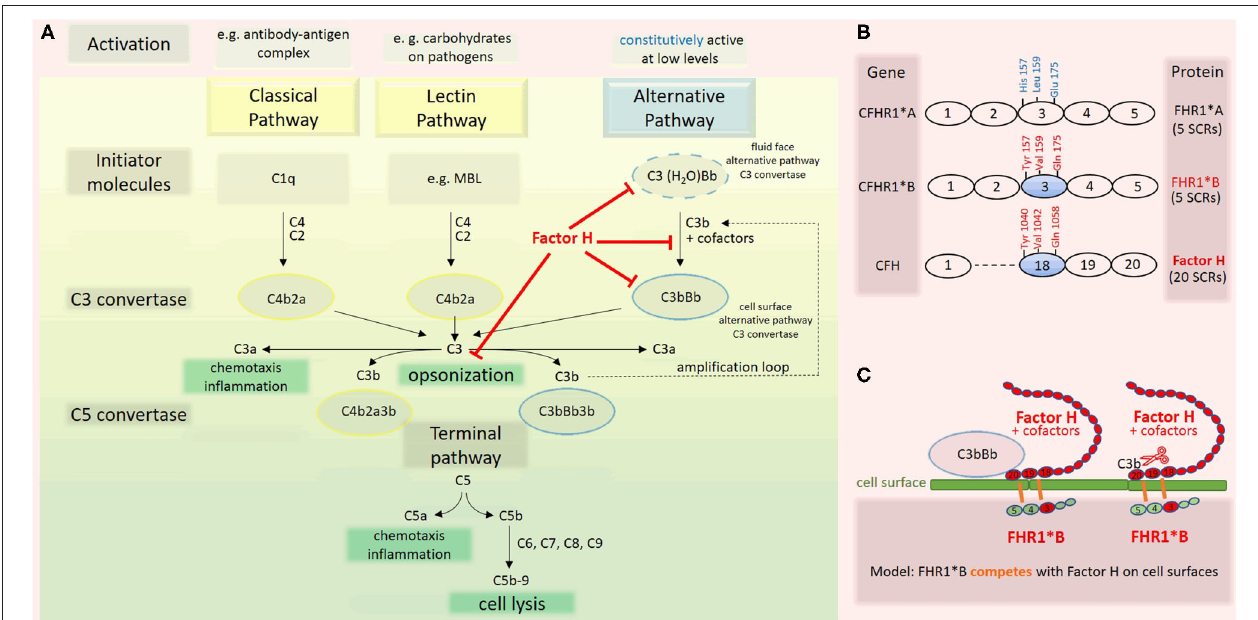
FIGURE 2 | Complement activation cascade. Factor H and factor H related (FHR) 1 allotypes. (A) The complement system has three pathways (8). The classical pathway (CP) is triggered by antibody-antigen complexes interacting with C1q. The lectin pathway (LC) is triggered when lectins, e.g., mannose binding lectin